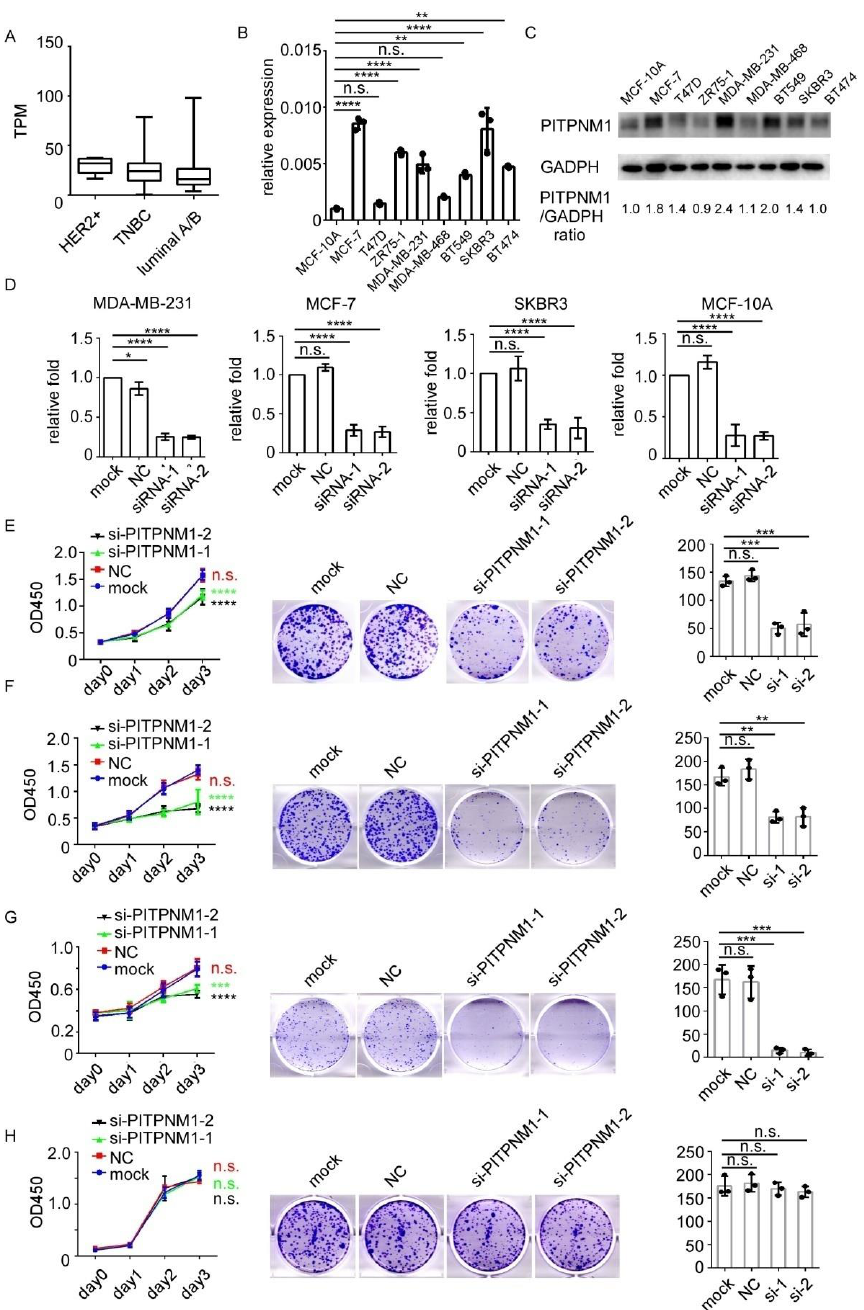
Figure 3. Silencing of PITPNM1 inhibits breast cancer proliferation. ( A ) The expression of PITPNM1 in different breast cancer subtypes. ( B ) The expression of PITPNM1 in breast cancer cell line validated by qPCR. n.s., not significant, p > 0.05; * p < 0.05; ** p < 0.01; *** p < 0.001; **** p < 0.0001. ( C ) The expression of PITPNM1 in breast cancer cell line validated by Western Blot. ( D ) siRNAs transfection efficiency validated by qPCR in four cell lines. n.s., not significant, p > 0.05, * p < 0.05; **** p < 0.0001. ( E ) The proliferation ability of MDA-MB-231 determined by the CCK8 assay and colony formation. n.s., not significant, p > 0.05; * p < 0.05; *** p < 0.001; **** p < 0.0001. ( F ) The proliferation ability of MCF-7 determined by the CCK8 assay and colony formation. n.s., not significant, p > 0.05; * p < 0.05; ** p < 0.01; **** p < 0.0001. ( G ) The proliferation ability of SKBR3 determined by the CCK8 assay and colony formation. n.s., not significant, p > 0.05; * p < 0.05; *** p < 0.001; **** p < 0.0001. ( H ) The proliferation ability of MCF-10A determined by the CCK8 assay and colony formation. n.s., not significant, p >